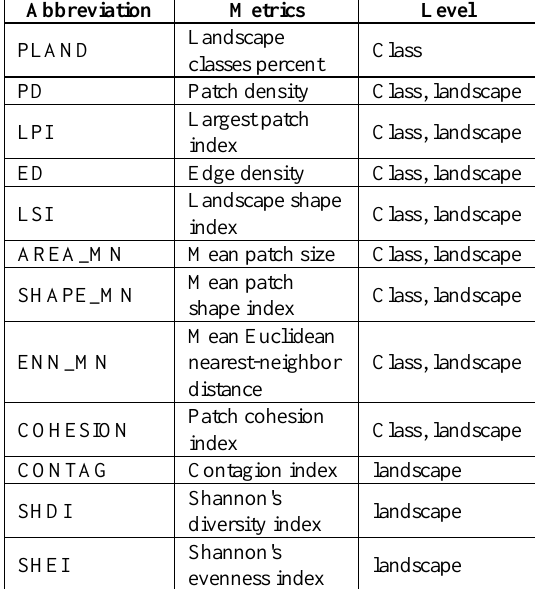
Table 1. Landscape metrics used in this